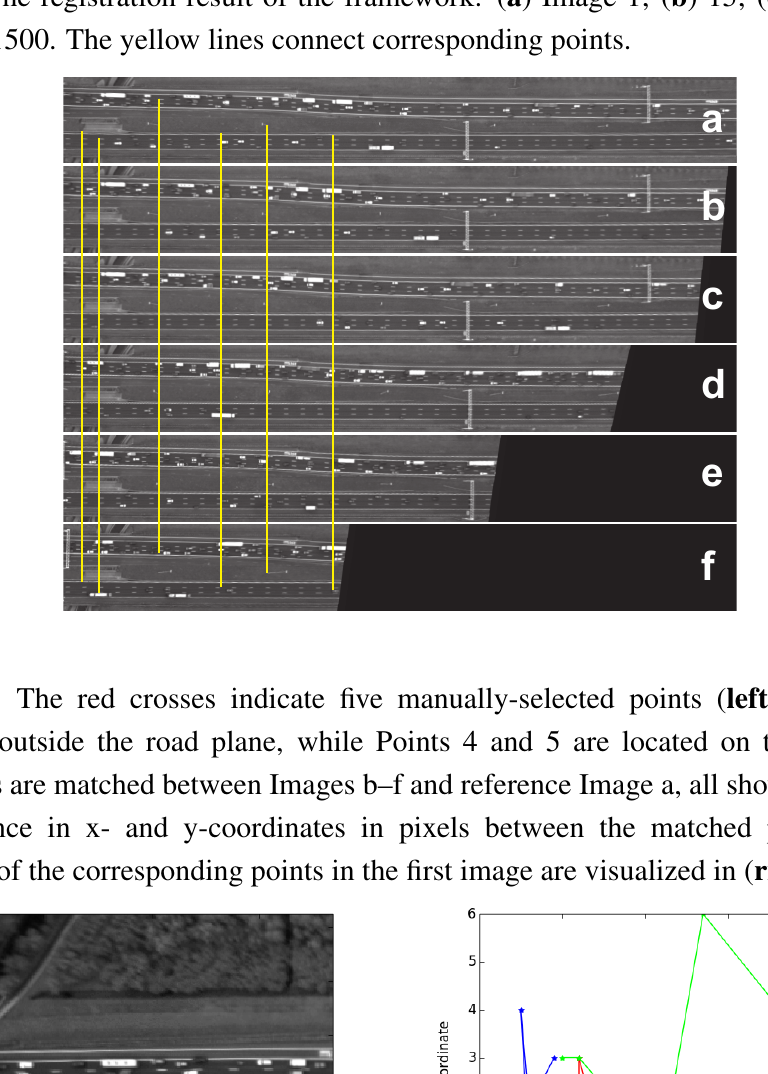
Figure 9. The registration result of the framework: ( a ) Image 1; ( b ) 15; ( c ) 59; ( d ) 661; ( e ) 991; ( f ) 1500. The yellow lines connect corresponding points.